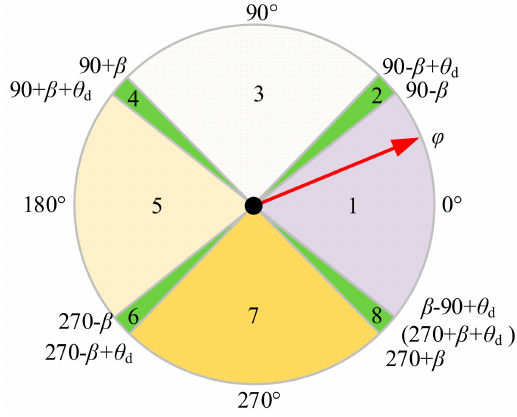
Figure 3. Operating regions of DAB WPT system with dead